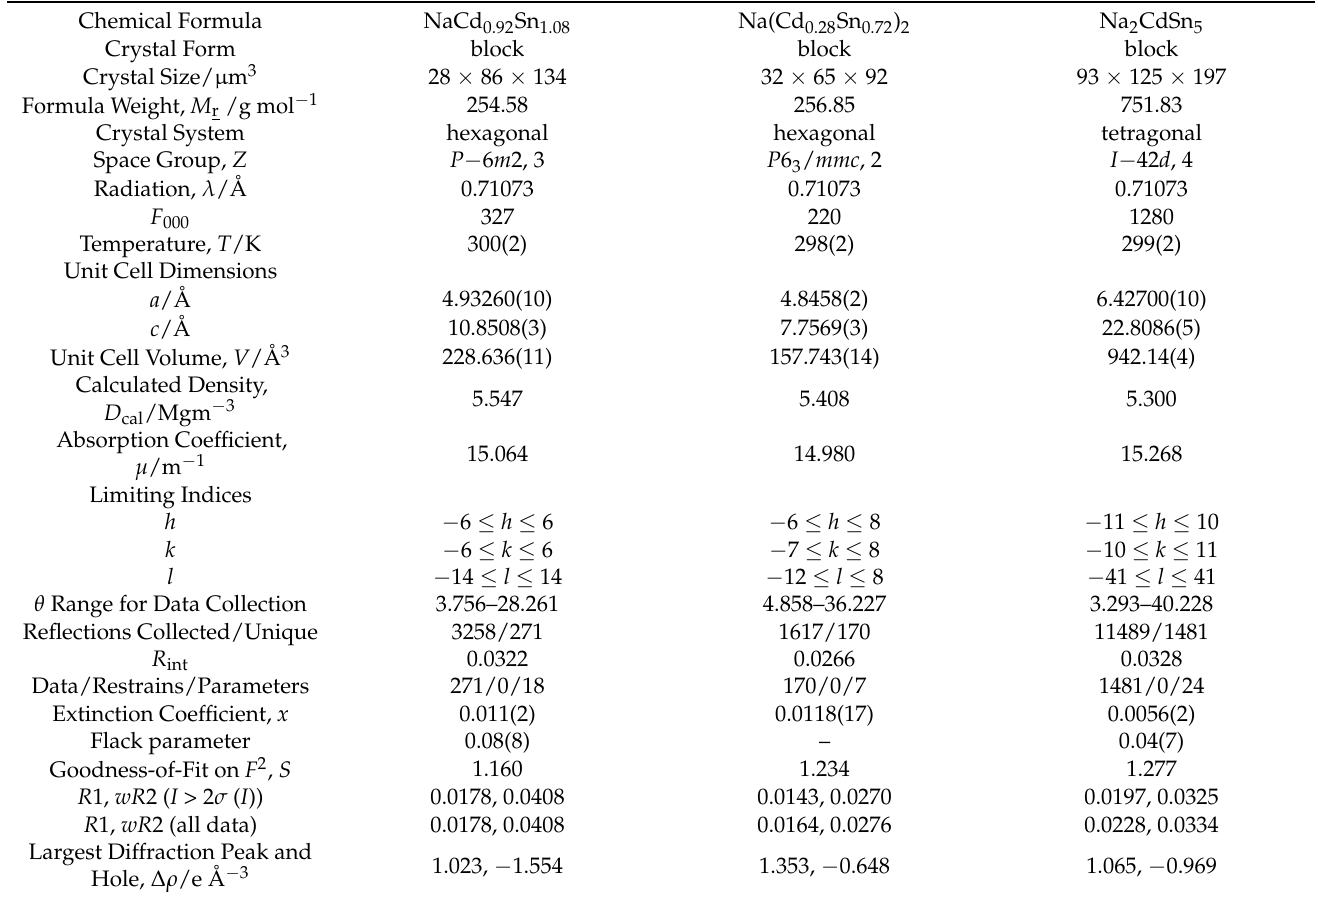
Table 1. Crystallographic data for NaCd 0.92 Sn 1.08 , Na(Cd 0.28 Sn 0.72 ) 2 , and tI -Na 2 CdSn 5 .